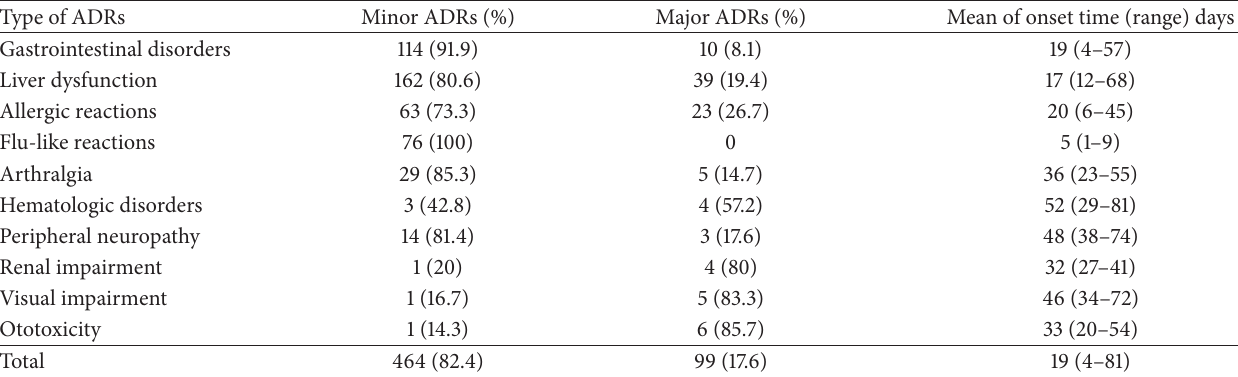
Table 1: Incidence, onset time ∗ , and seriousness of anti-TB adverse drug